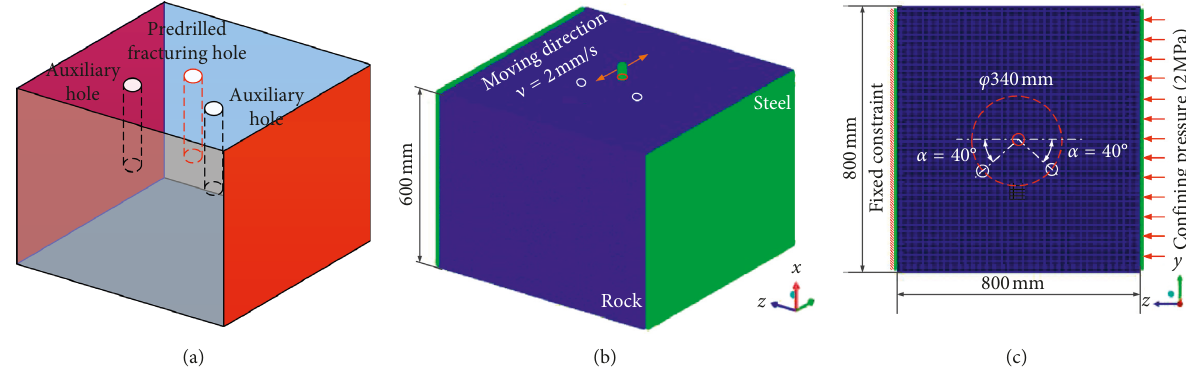
Figure 6: (a) Geometric model; (b) numerical model; (c) boundary conditions.